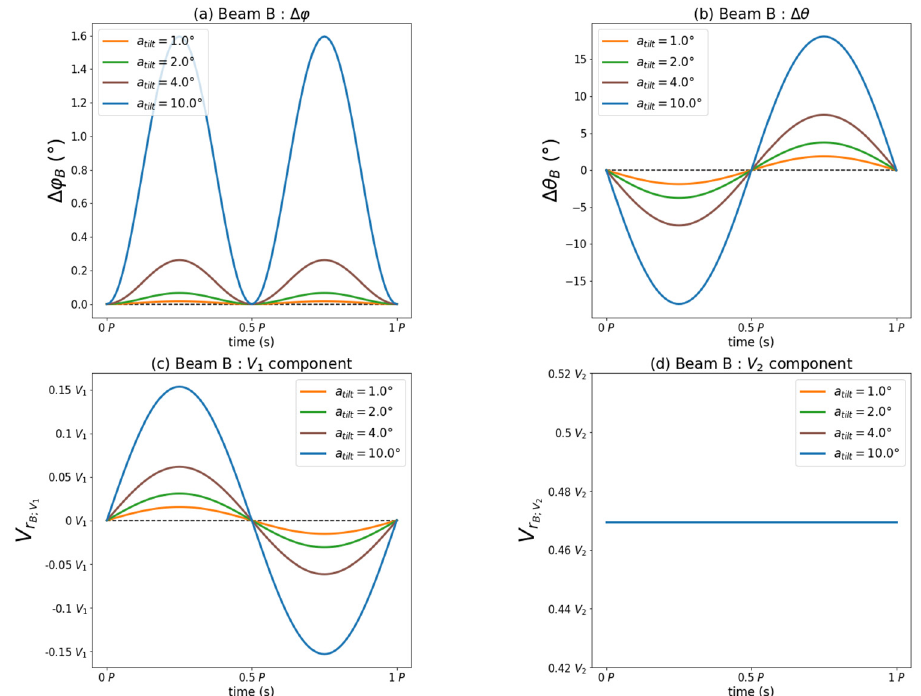
Figure 6. Response of the beam B to a sinusoidal motion of tilt T as a function of the incident wind components V 1 and V 2 . The results are plotted as a function of the time relative to the period of the sinusoid. ( a ) Motion-induced variation of the angle ϕ . ( b ) Motion-induced variation of the angle θ . ( c ) Variation of the component according to V 1 of the radial wind speed. ( d ) Variation of the V 2 component of the radial wind speed.